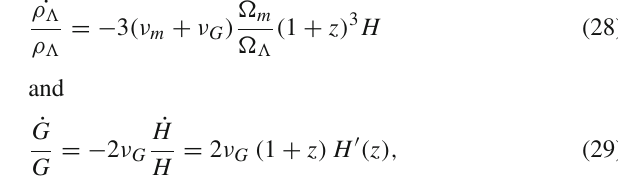
Fig. 4 The mild time evolution of the baryon masses ( dashed line ) versus the more substantial evolution of the DM particle masses ( solid line ). As before, ν B = 10 − 5 and ν X = 10 − 3